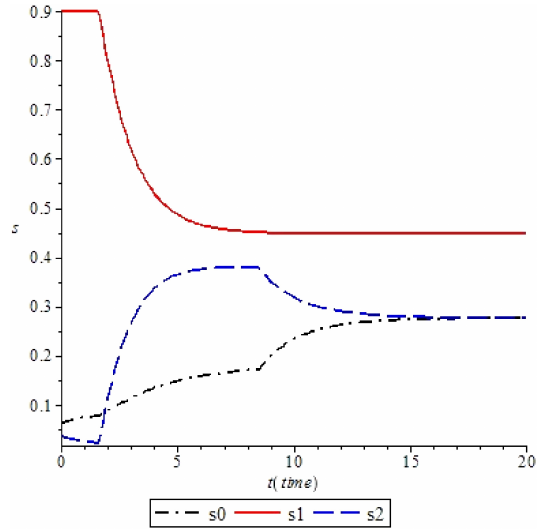
Fig. 7. Graphs of the optimal distribution of investment resources.